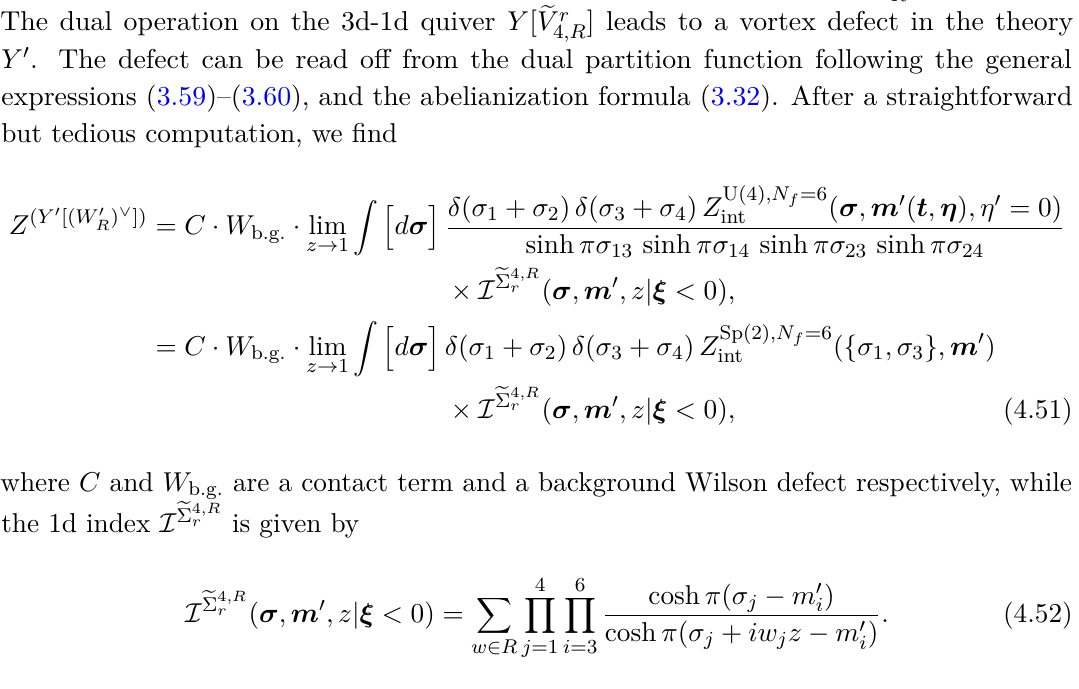
] and Y [ e V l ] 4 ,R 4 ,R